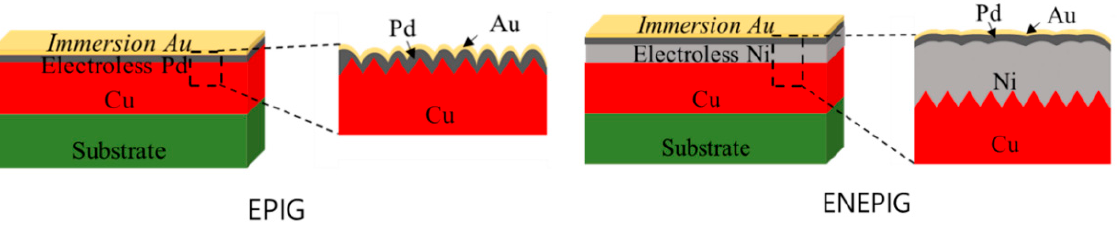
Figure 9. Schematics that explain the surface roughness difference between EPIG and ENEPIG sur- face finishes. face